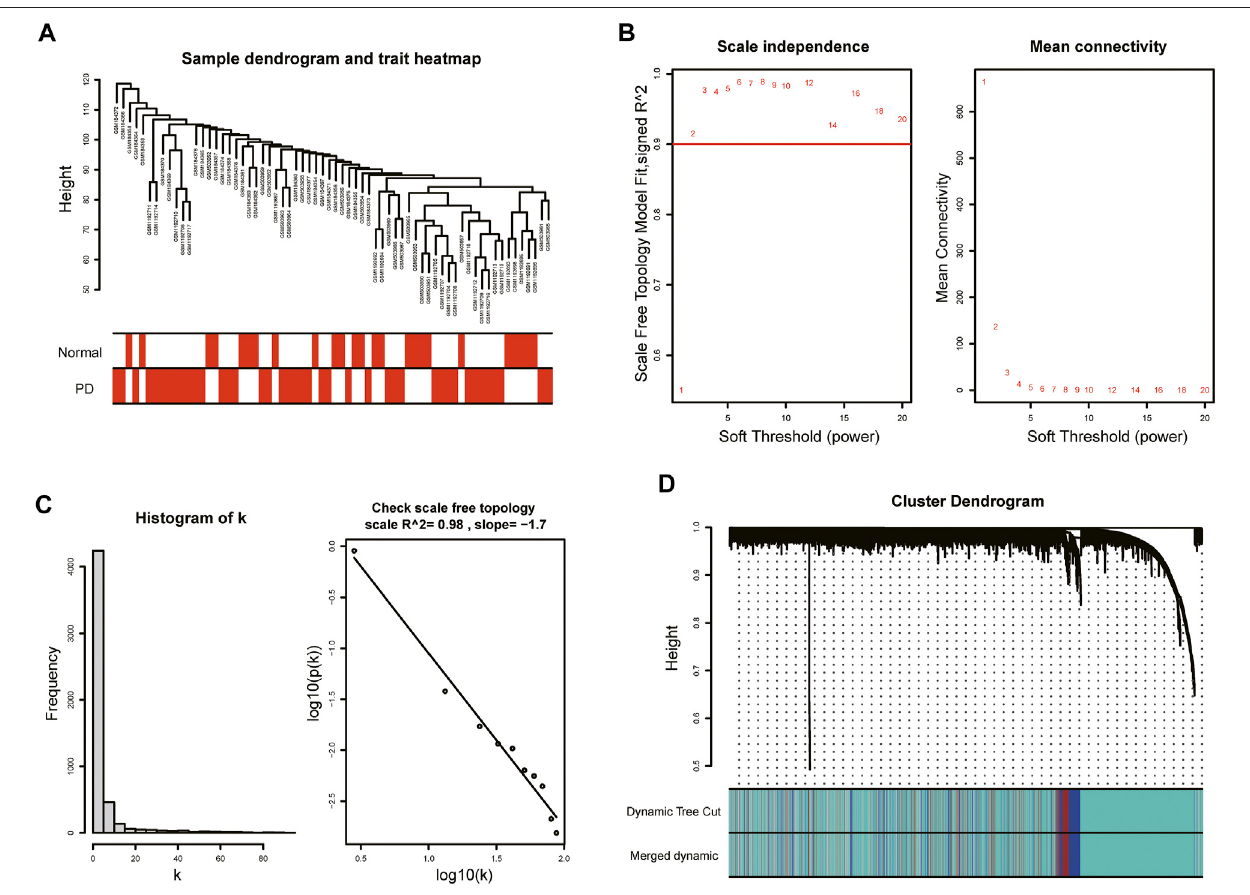
FIGURE2| WGCNAofGSE7621,GSE20141,andGSE49036. (A) Sampledendrogramandtraitheatmap. (B) Thevaluesofsoft-thresholdpowerbasedonscale independence and mean connectivity. The soft-threshold power was selected as 5 to satisfy the criteria of scale-free topology. (C) Check scale-free topology. The correlation coef fi cient of the connection degree k and p(k) was 0.98, indicating scale-free topology was constructed. (D) Cluster dendrogram of genes. Each color represented a module, and the gray module included the genes that could not be classi fi ed into any module.